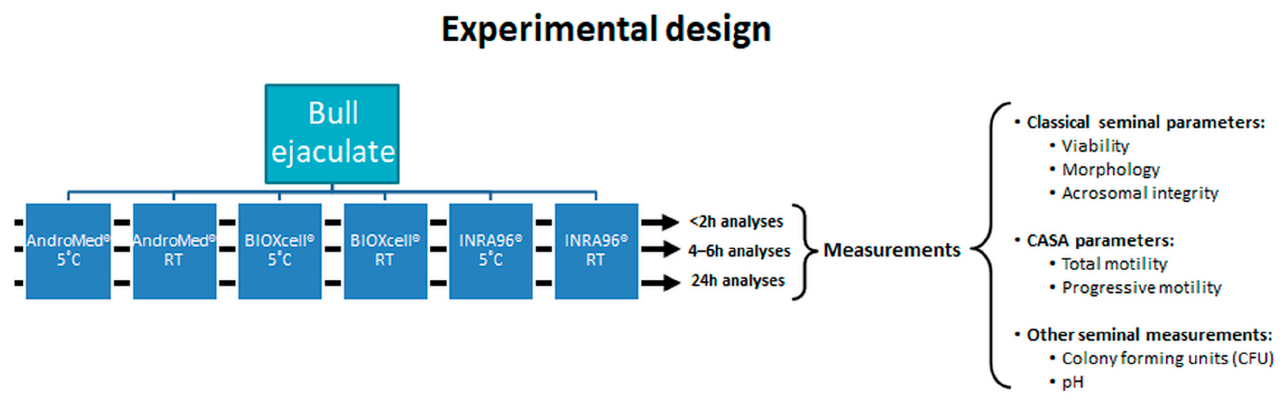
Figure 1. Experimental study design (3 × 3 × 2) involving three extenders, two holding temperatures, and three storage durations. Abbreviations: CASA = computer-assisted semen-analysis; RT = room temperature.